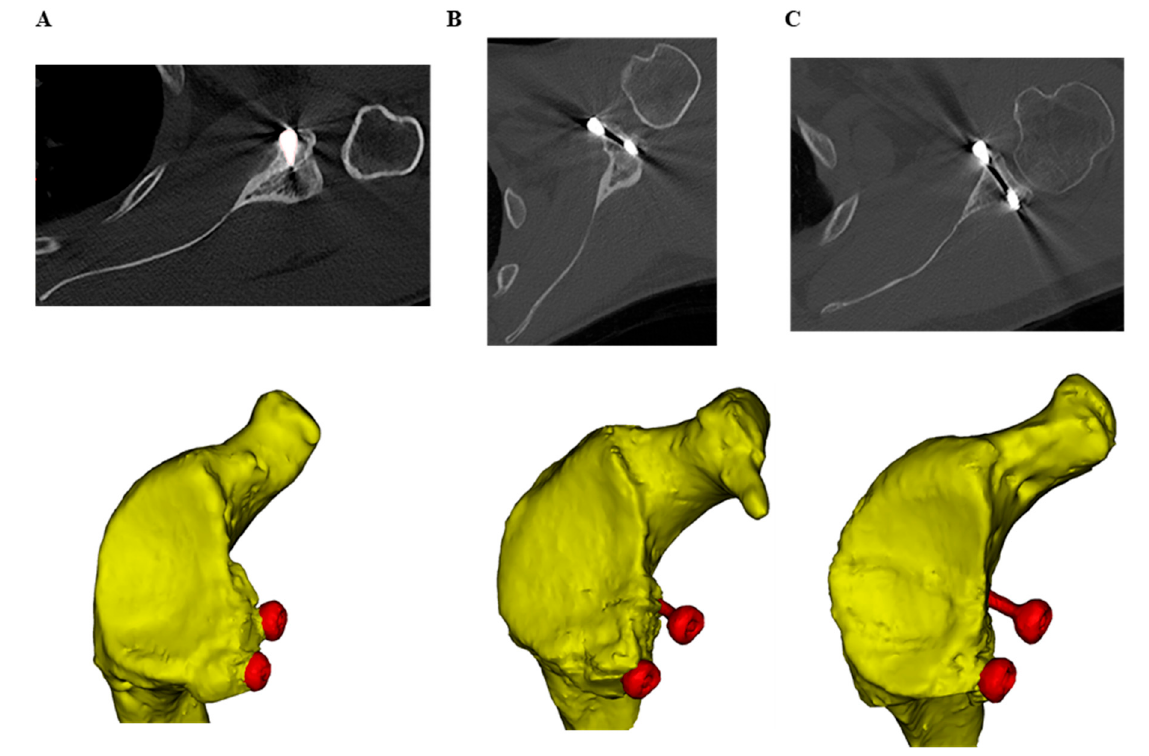
Figure 1. Resorption grades on the final follow-up axial CT scans, as defined by Zhu et al. (2015) [11], with the corresponding three-dimensional scapula geometries (yellow) and screws (red) generated by segmentation of CT scans of three different participants. ( A ) Grade I (minor resorption), ( B ) Grade II (major resorption) and ( C ) Grade III resorption (total resorption).